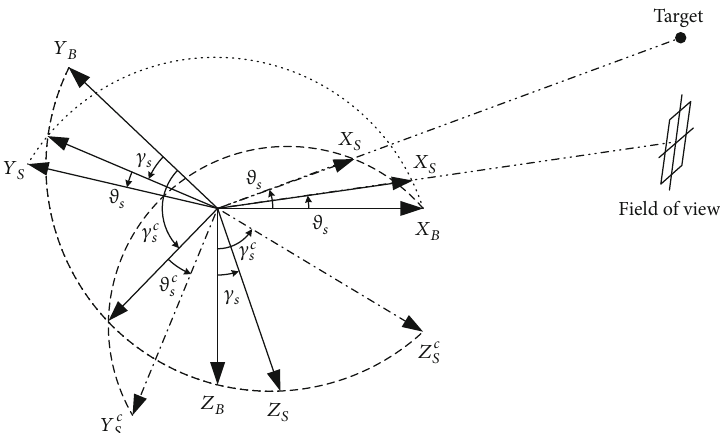
Figure 2: Schematic diagram of zenith pass problem ( γ c